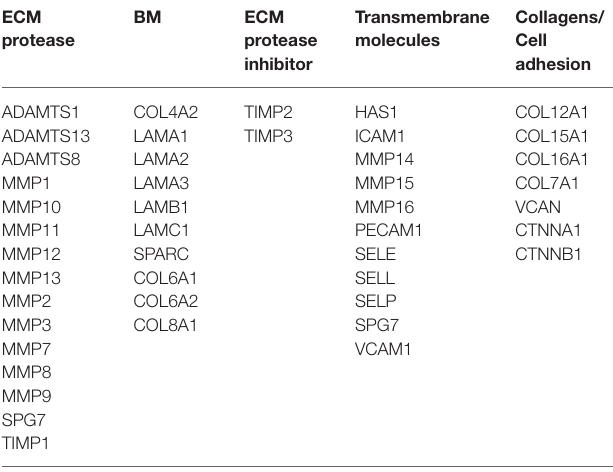
TABLE 3 | ECM-associated individual genes and proteins reported to influence patient prognostics and drug resistance a,c .